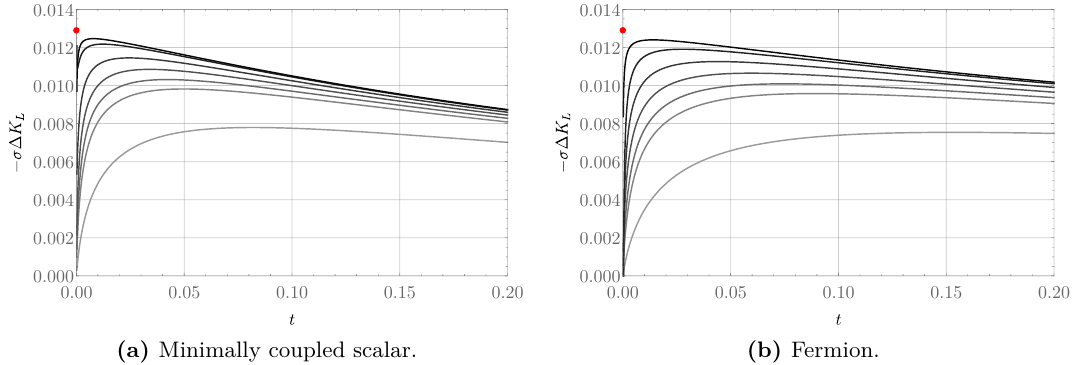
Figure 8. The small- t behavior of ∆ K L for the minimally coupled scalar (left) and the Dirac fermion (right) on the geometries described by the embedding (5.5). From lightest to darkest, the curves correspond to (cid:15) = 0 . 9 , 0 . 95 , 0 . 96 , 0 . 97 , 0 . 98 , 0 . 99 , and 0 . 995 . The red dot indicates the t = 0 value (5.6) expected on the conical defect geometry corresponding to (cid:15) = 1